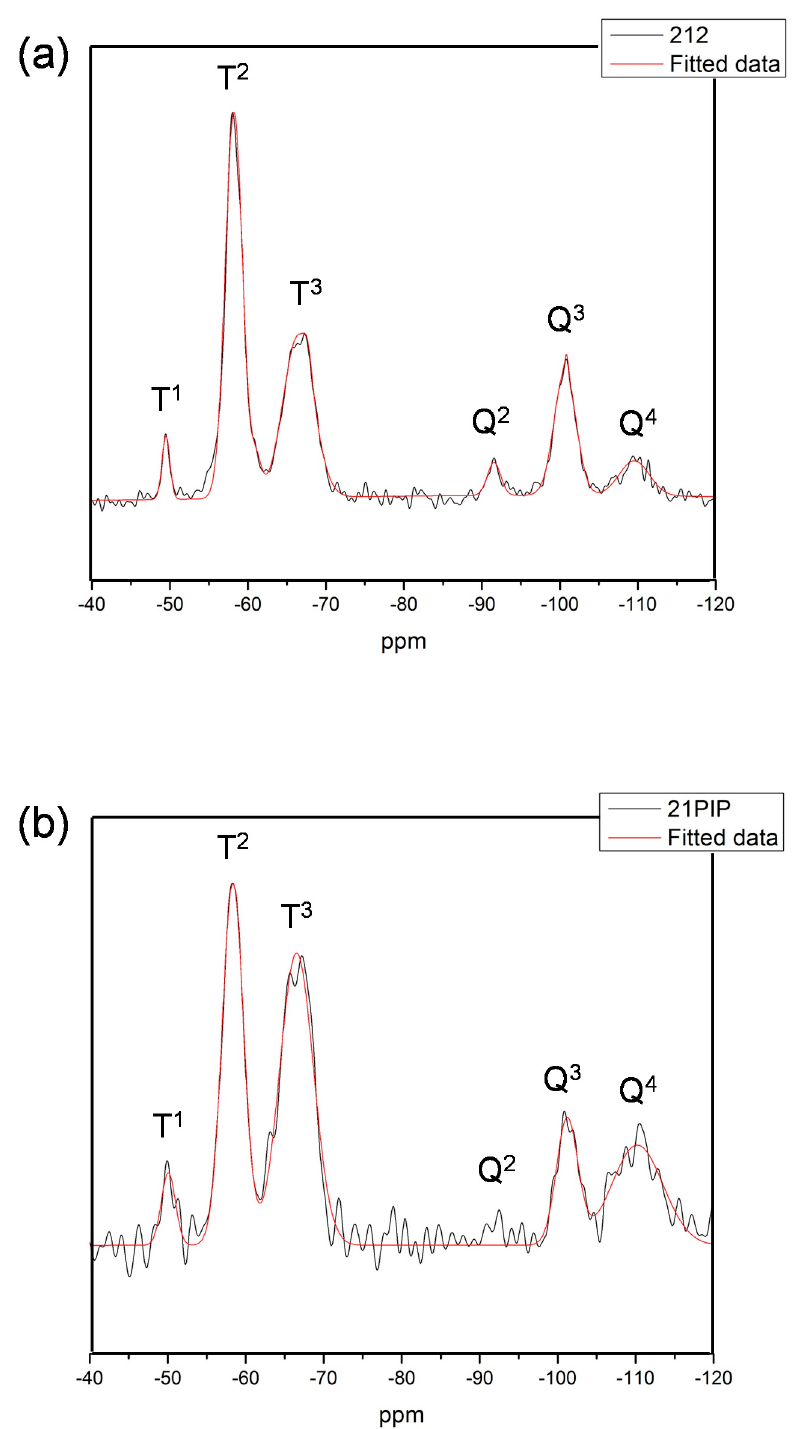
and 21PIP ( b ) Figure 8 . 29 Si-NMR spectra and the different Q and T groups identified from the spectra in the 212 ( a ) and 21PIP ( b ) samples.